Question: Which kind of chart has been used to present this data?
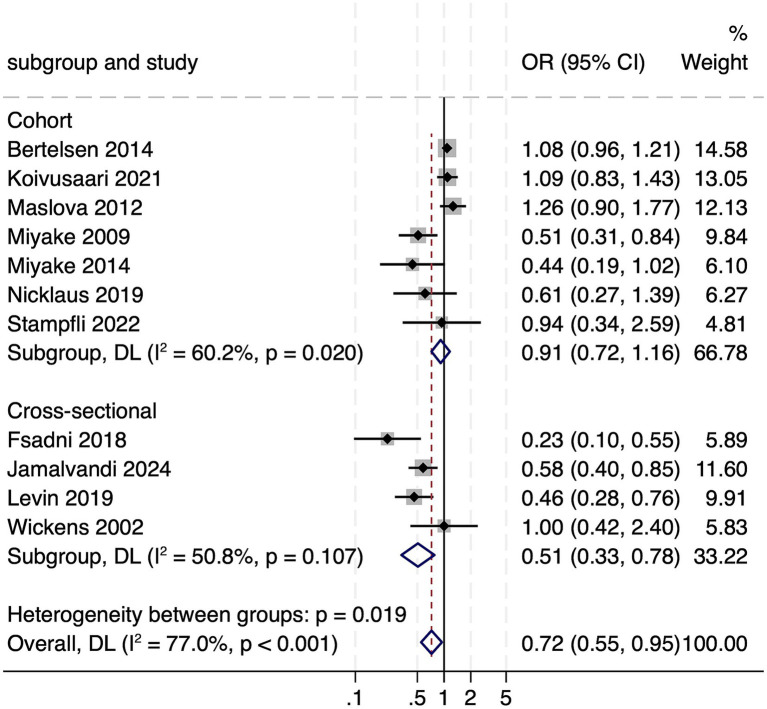
Answer: forest